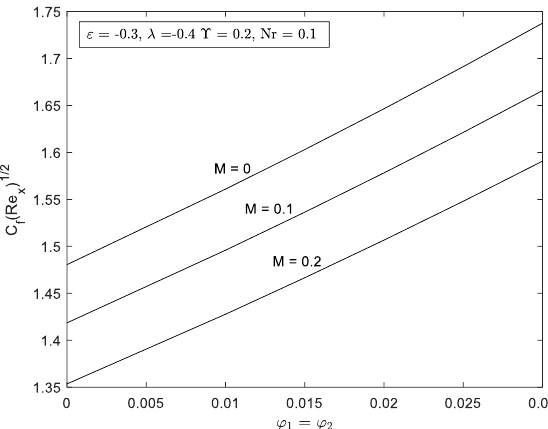
𝟏 𝟏 𝟐 for several M with 𝜑 1 = 𝜑 2 . 𝟏 1 𝟐 for several M with 𝜑 1 = 𝜑 2 . 2 for several M with ϕ 1 = ϕ 2 𝟐 for several M with 𝜑 1 = 𝜑 2 . Figure 10. C f ( Re x )